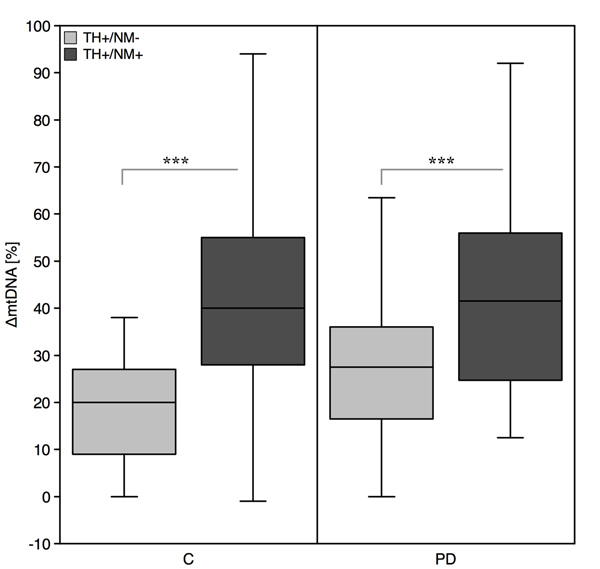
Levels of mitochondrial DNA deletions in nigral neurons of PD and controls. Pigmented neurons (TH+/NM+) of the SNc have considerably higher ΔmtDNA levels than non-pigmented neurons (TH+/NM-) in controls (C) and PD (*** p = 0.001). In nonpigmented neurons there was a trend to higher deletions in PD vs. controls (p = 0.052).